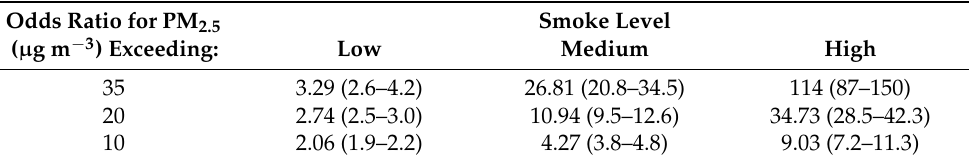
Figure 2. Boxplots showing the distribution of fine particulate matter (PM 2.5 ) on days with no smoke from fires relative to days with low, medium, or high levels of smoke. Table 1. Estimated odds ratios (with 95% confidence interval) for PM 2.5 exceeding 35, 20, or 10 µg m −3 relative to odds on days with no smoke above.